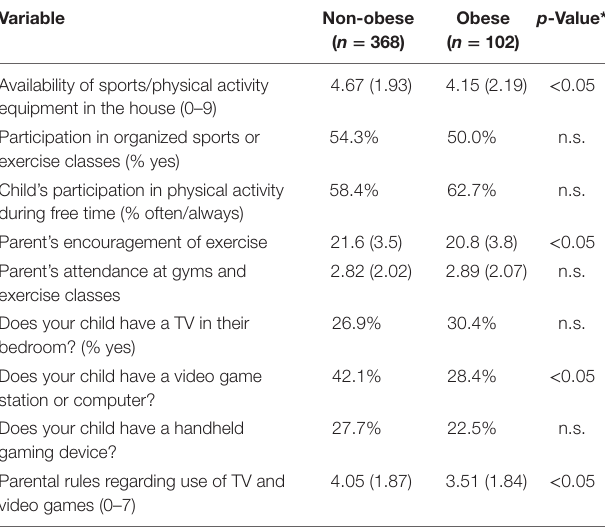
TaBle 2 | Physical activity and sedentary behaviors by child’s obesity